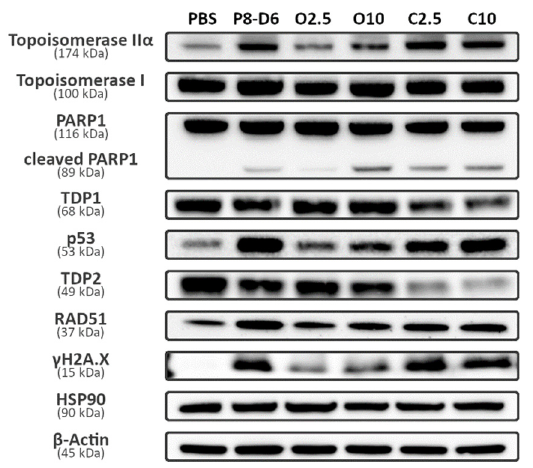
Figure 8. Protein expressions modulated by combinational treatment of PARP and P8-D6. Western blot analysis was performed for several cellular proteins associated with DNA damage repair sys- tems using total OvCar8 cell lysate. HSP90 and β -Actin were used as loading control. O2.5— olaparib 2.5 µM, O10—olaparib 10 µM, C2.5—combination of olaparib 2.5 µM and P8-D6 0.1 µM, C10—combination of olaparib 10 µM and P8-D6 0.1